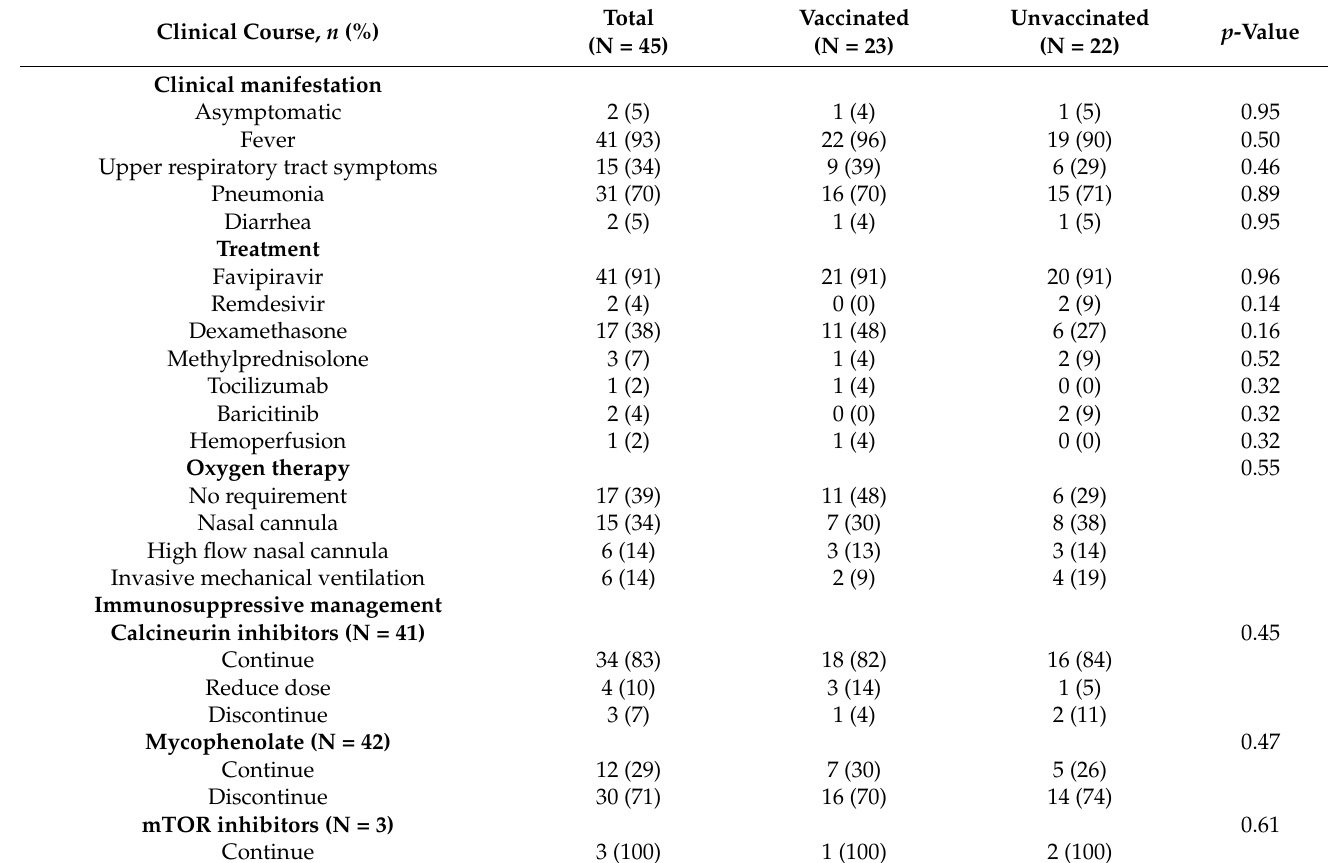
Table 2. Hospital course of COVID-19 infection in kidney transplant